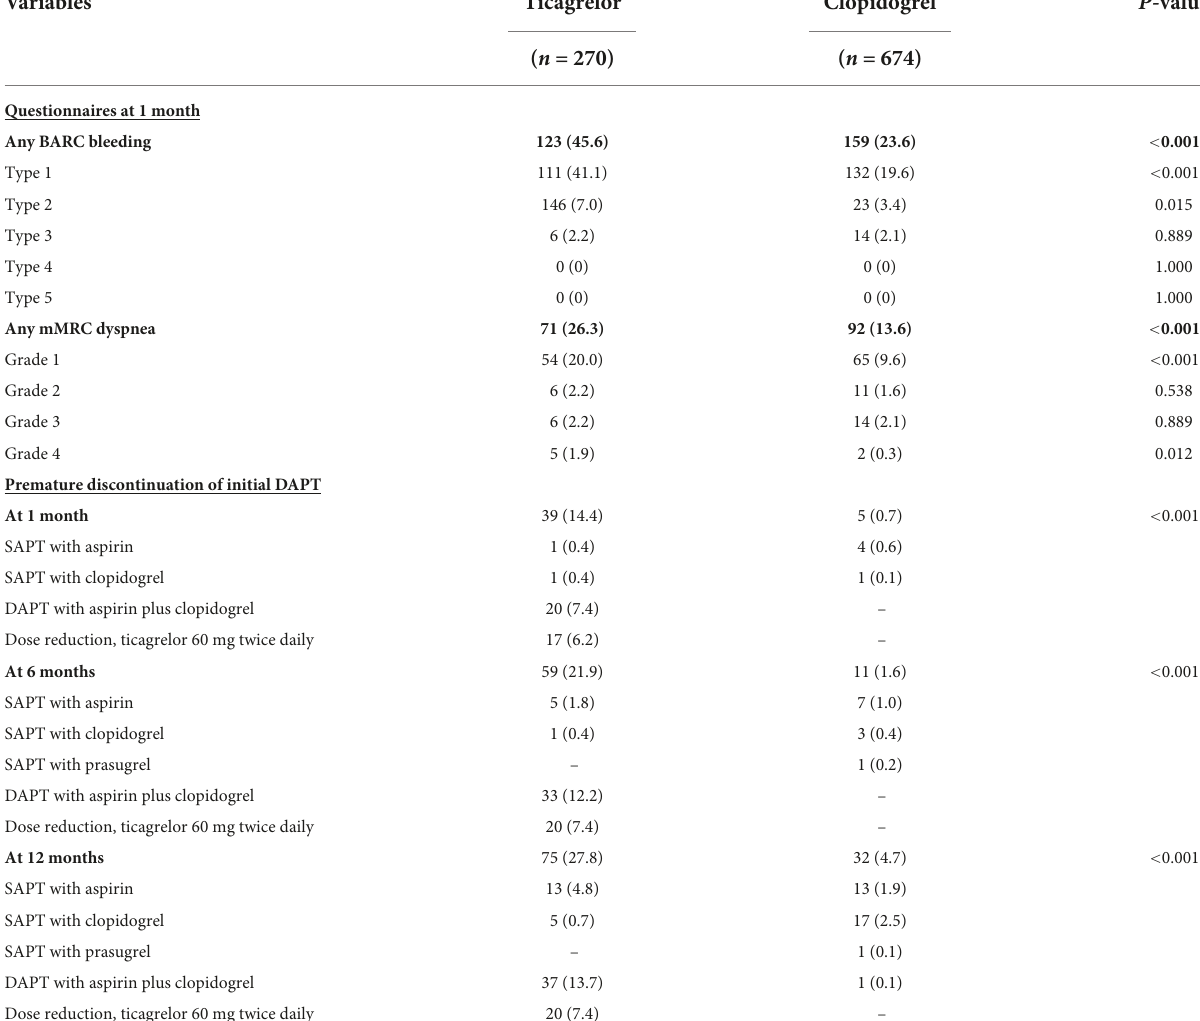
TABLE 3 Bleeding, dyspnea and premature discontinuation of initial dual antiplatelet therapy. Variables Ticagrelor